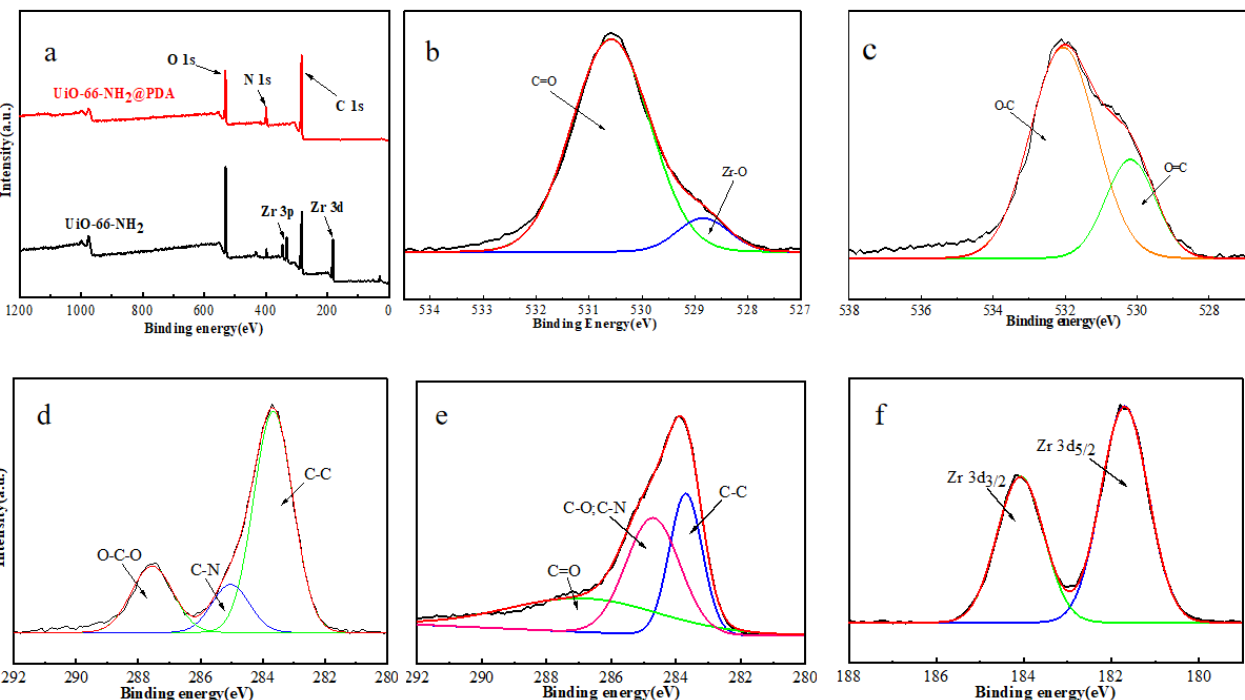
Figure 5. XPS survey spectra of: ( a ) UiO-66-NH 2 and UiO-66-NH 2 @PDA nanostructures, ( b ) high-resolution O 1s core level for UiO-66-NH 2 , ( c ) high-resolution O 1s core level for UiO-66-NH 2 @PDA, ( d ) high-resolution C 1s core level for UiO-66-NH 2 , ( e ) high-resolution C 1s core level for UiO-66-NH 2 @PDA, and ( f ) high-resolution Zr 3d core level for UiO-66-NH 2 .